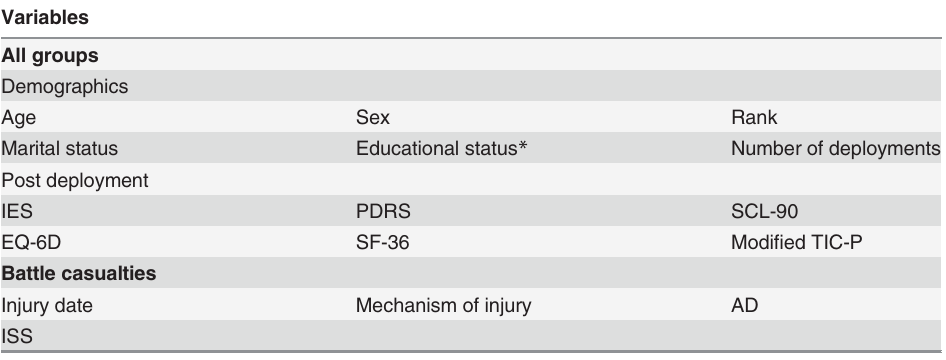
Table 1. Variables